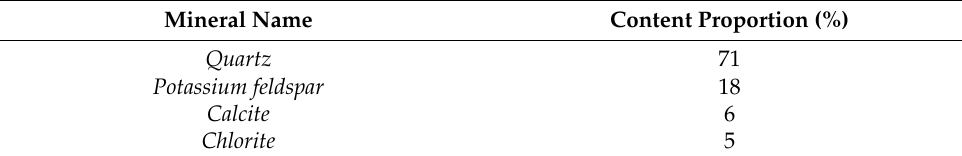
Table 2. Mineral composition in Samples B1 and B2.